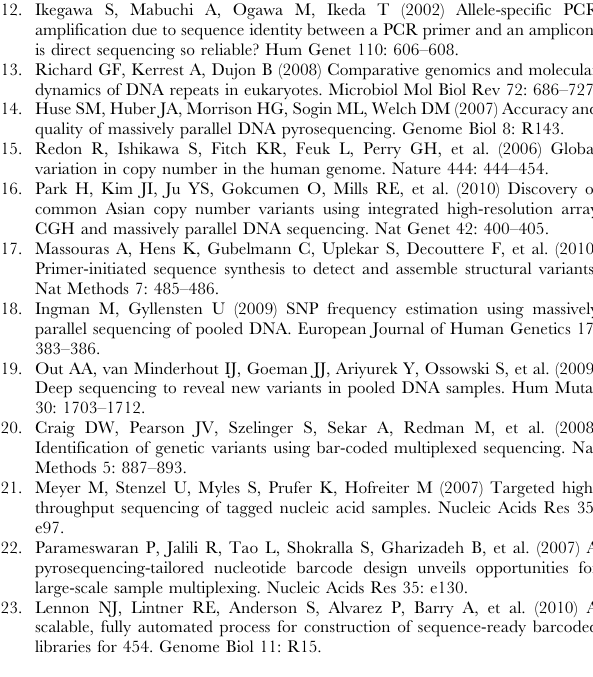
Table S3 SNPs detected after mapping of UHTS untrimmed reads. Black: SNPs detected by using the default threshold for heterozygozity (20%). Red: SNPs detected with a threshold between 10% and 20%. Blue: SNPs with a borderline limit definition of homo-heterozygosity. Green: variants corresponding to the CAAG insertion. Grey shadow: SNPs located in the 2nd long range PCR fragment, showing allelic imbalance. SNPs identified in the tandem repeats are not reported.